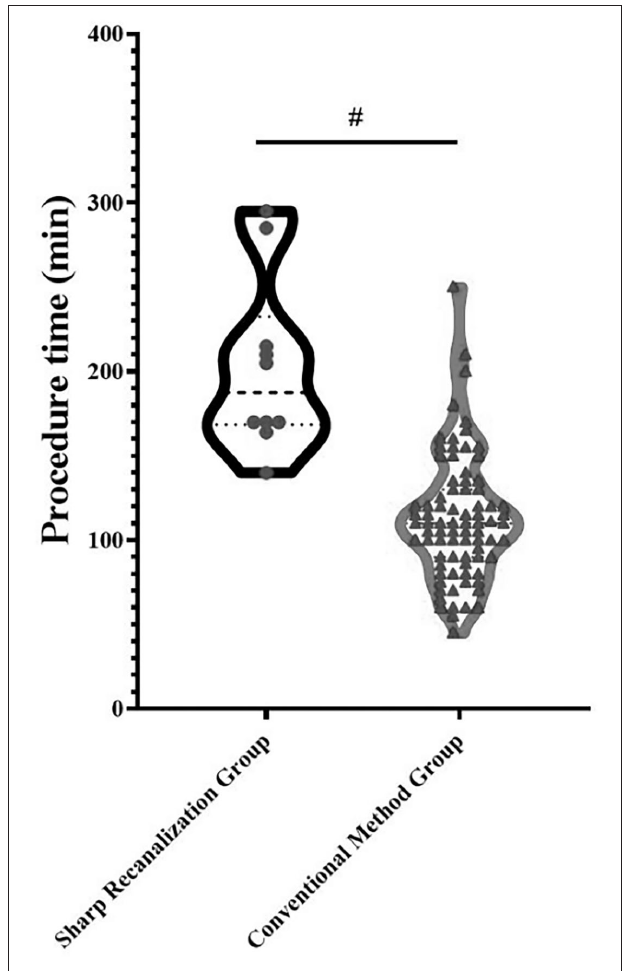
FIGURE 6 | Comparison of procedure time between the sharp needle recanalization group and conventional method group; # P < 0.001.